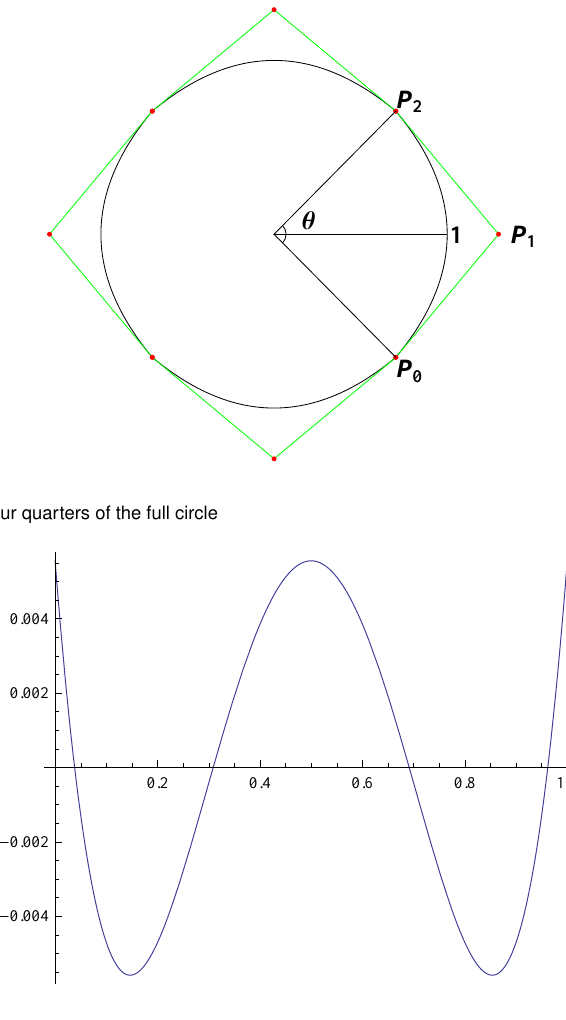
Fig. 5. The figure of the full circle using four Bézier curves